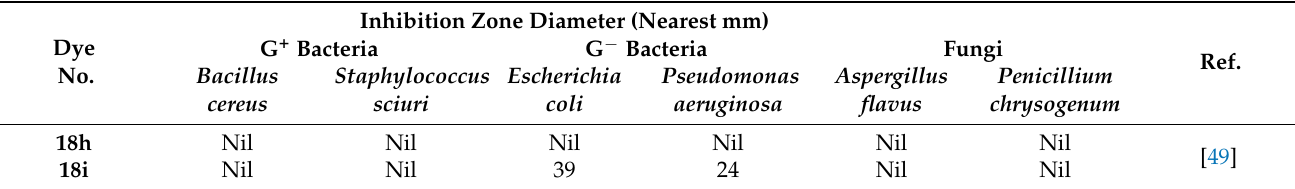
Table 6. Antimicrobial activity of the dyed polyester fabrics with dyes 18h and 18i. Inhibition Zone Diameter (Nearest mm) Dye Ref.G + No.